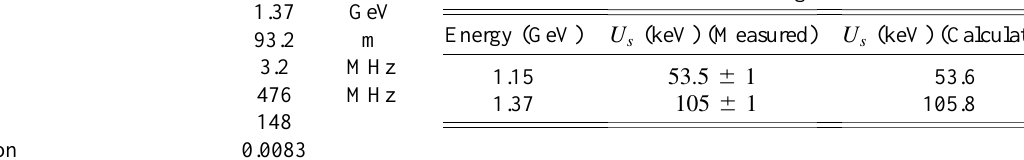
TABLE II. Measured and calculated energy loss to synchrotron radiation at two different beam energies. Energy (GeV)